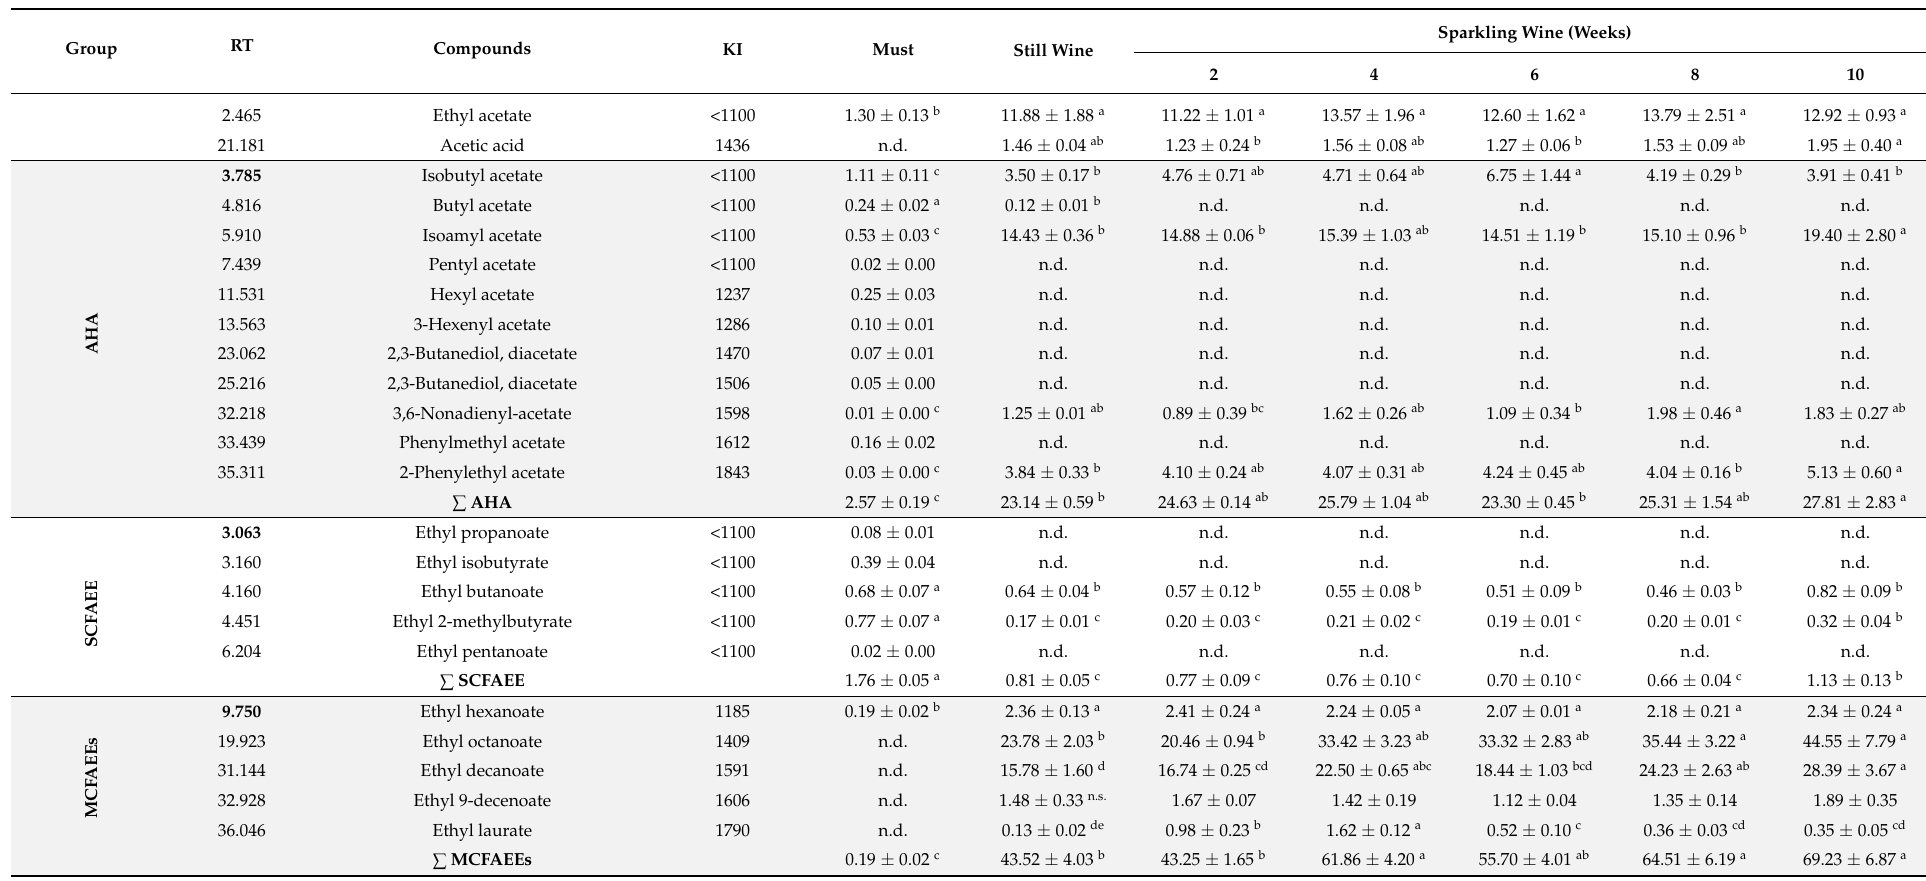
Table 6. Evolution of aroma volatiles (mg/L) in enriched must, still wine, and during the sparkling process of melon-based wine (10